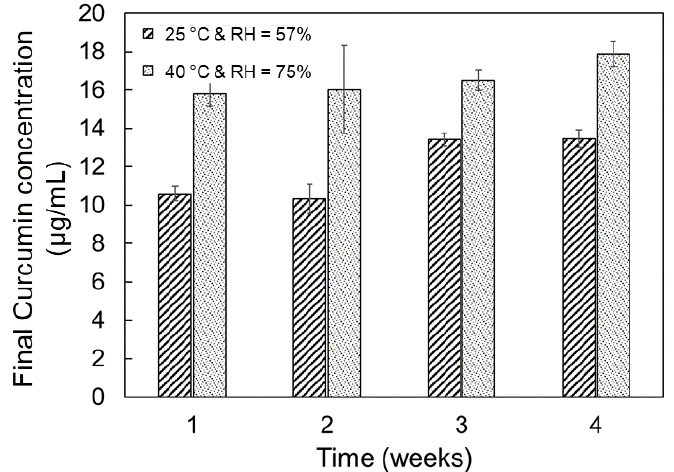
Figure 7. Free curcumin concentration based on HPLC analysis (elution between 5 and 6 min) of the final degradation supernatants collected from the dissolution of PCBAE prodrug tablets stored at standard and accelerated conditions.